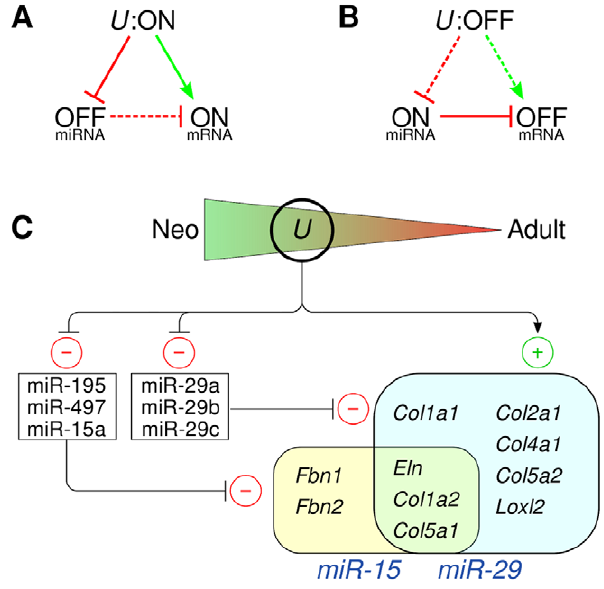
Figure 7. Putative model for a feed-forward miRNA/mRNA network controlling expression of key ECM genes in the developing aorta. U denotes upstream factors which tend to up- regulate ECM genes in the neonatal aorta and to suppress miR-29 and miR-15 family microRNAs. TGF- b and Wnt signaling could be among the upstream factors (see text). A Neonatal aorta. If upstream factors are active (‘‘U: ON ’’), they repress the expression of the miRNAs and induce the expression of numerous ECM genes such as Eln . B Adult aorta. If the upstream factors are inactive (‘‘U: OFF ’’), there is less induction of the ECM genes. The miRNAs are no longer repressed, so that their expression levels increase and thereby provide an additional element of repression for the expression of the target mRNAs. In (A) and (B), green arrows indicate positive regulation, and red lines with bars negative regulation. Solid lines indicate that the regulatory reaction is active, and dashed lines indicate that it is inactive. C Putative model of miR-15/miR- 29 and mRNA target gene networks. In the adult aorta, ECM genes tend to be down-regulated and the miRNAs to be up-regulated. Ten significantly down-regulated ECM genes are shown. Eight of them have at least five MREs for miR-29, five have at least five MREs for miR-15, including three genes that additionally have at least five MREs for miR- 29.